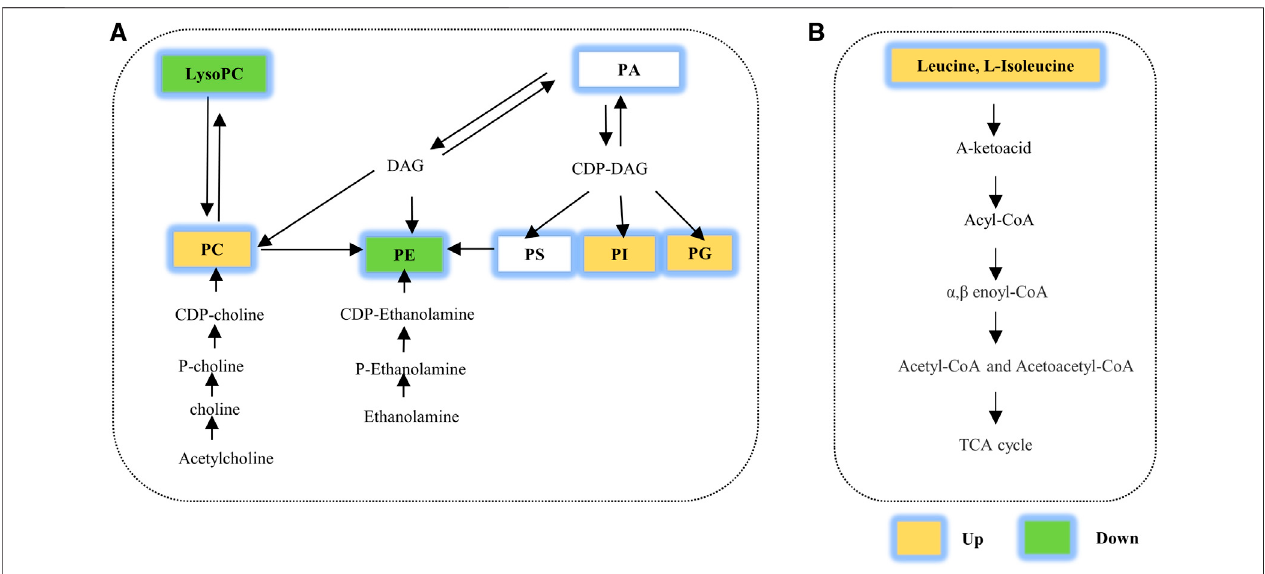
FIGURE 6 | Several metabolic pathways with perturbations were calculated in our study. Perturbation of (A) glycerophospholipid metabolism and (B) amino acid metabolism. TCA cycle, tricarboxylic acid cycle; 5-HT, 5-hydroxytryptamine; 5-HIAA, 5-hydroxyindoleacetic acid. PE: phosphatidylethanolamines; DAG, diacylglycerol; PC, phosphatidylcholine; PS, phosphatidylserine; PG, glycerophosphoglycerols; PI, glycerophosphoinositols; PA, phosphatidic